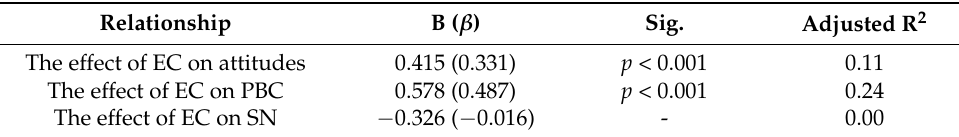
Table 5. Testing mediation, results from step